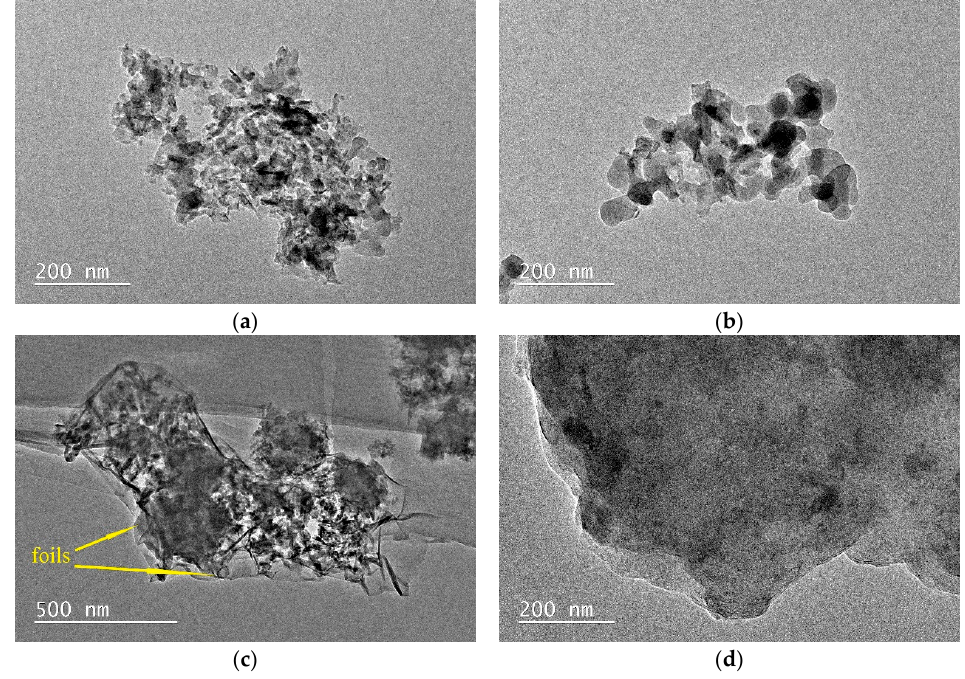
Figure 7. TEM images of K-A-S-H samples ( a ) K-A-S-H 2.0 2 -7d-60, ( b ) K-A-S-H 2.0 2 -3d-95, ( c ) K-A-S-H 0.5 2 -7d-95, ( d ) K-A-S-H 2.0 2 -7d-95.